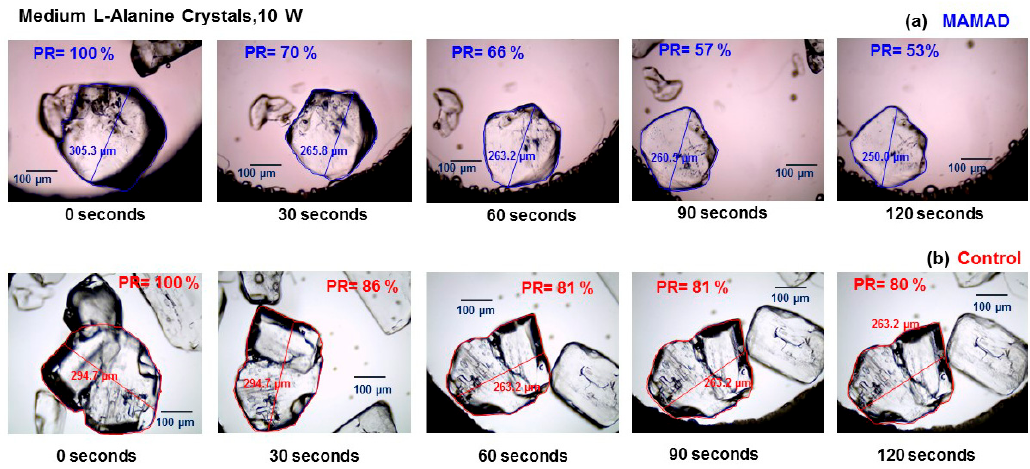
Figure 4. Optical images of medium-sized L -alanine crystals (initial size = 300 μ m) during 10 W microwave heating for 120 s ( a ) in the presence of gold nanoparticles (i.e., the MAMAD technique); and ( b ) in the absence of gold nanoparticles (control). PR = Percent Retention and refers to the ratio of the area of the crystal to the initial area of the crystal as outlined.